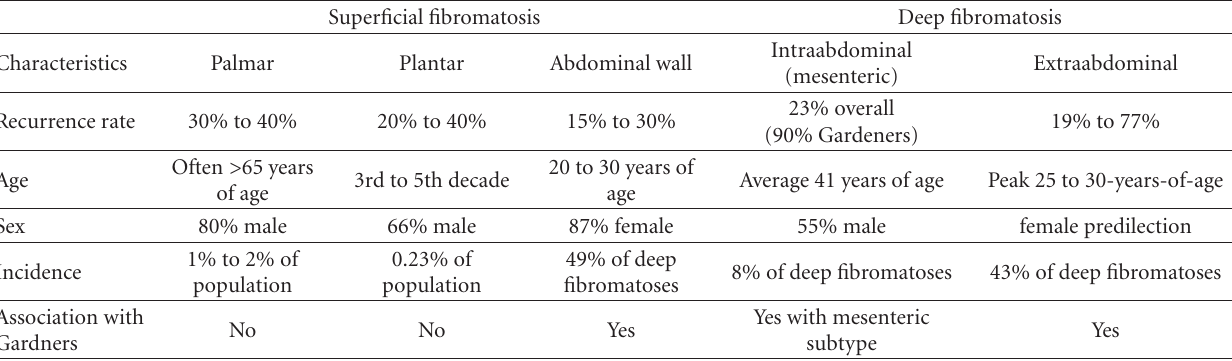
Table 1: Characteristics of superficial and deep fibromatoses. The overall incidence of deep fibromatosis is two to four individuals per million each